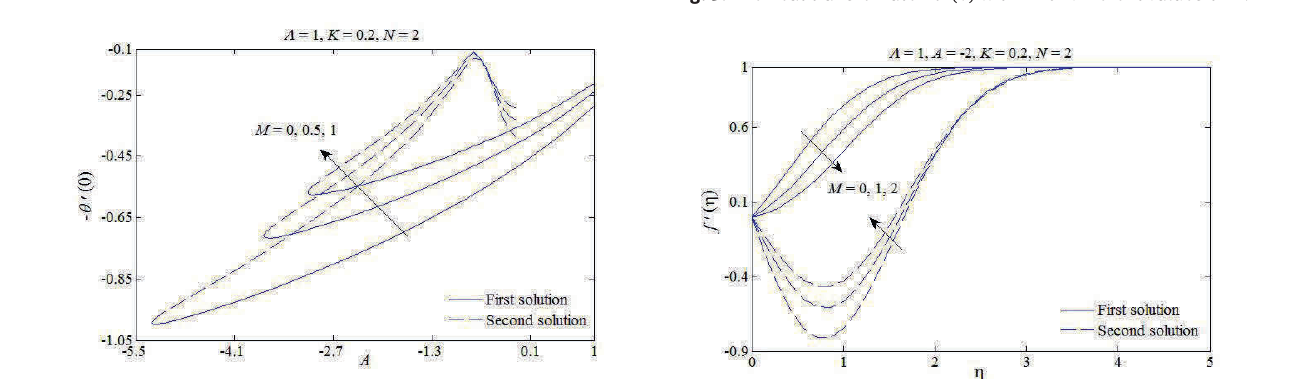
Fig. 5: The heat transfer rate − θ (cid:2) (0) with A for different values of K .